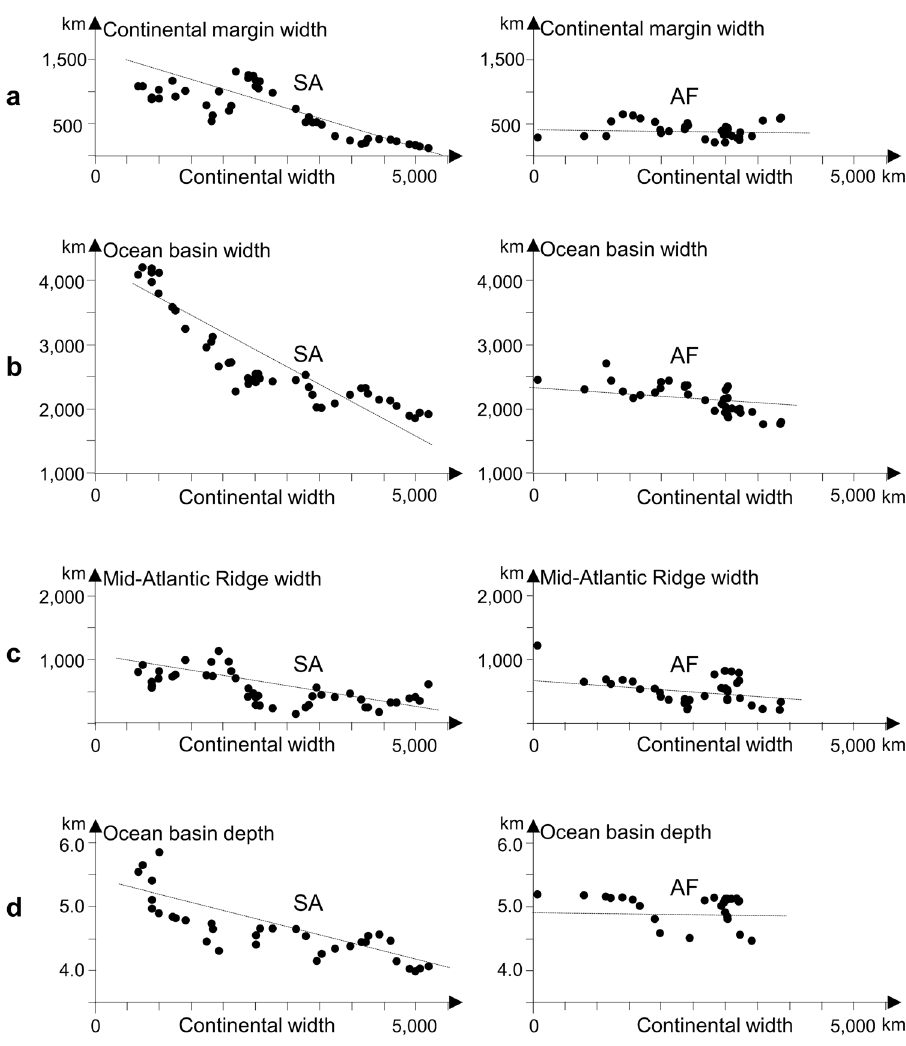
Fig. 6 Cross-correlations of continental width to bathymetry in the South American (SA) and the African (AF) Atlantic. The original base map and data samples are shown in Supplementary Figs. 2, 3, respectively. Note the South American continent (left) has a much higher correlation to bathymetry than the African continent (right). a Continental margin width cross plotting with continental width of South America (left) and Africa (right). b Ocean basin width cross plotting with continental width of South America (left) and Africa (right). c Mid-Atlantic Ridge width cross plotting with continental width of South America (left) and Africa (right). d Ocean basin depth cross plotting with continental width of South America (left) and Africa (right). Anomalous depth samples at the Rio Grande Rise and the Walvis Ridge are removed to better represent the regional depth